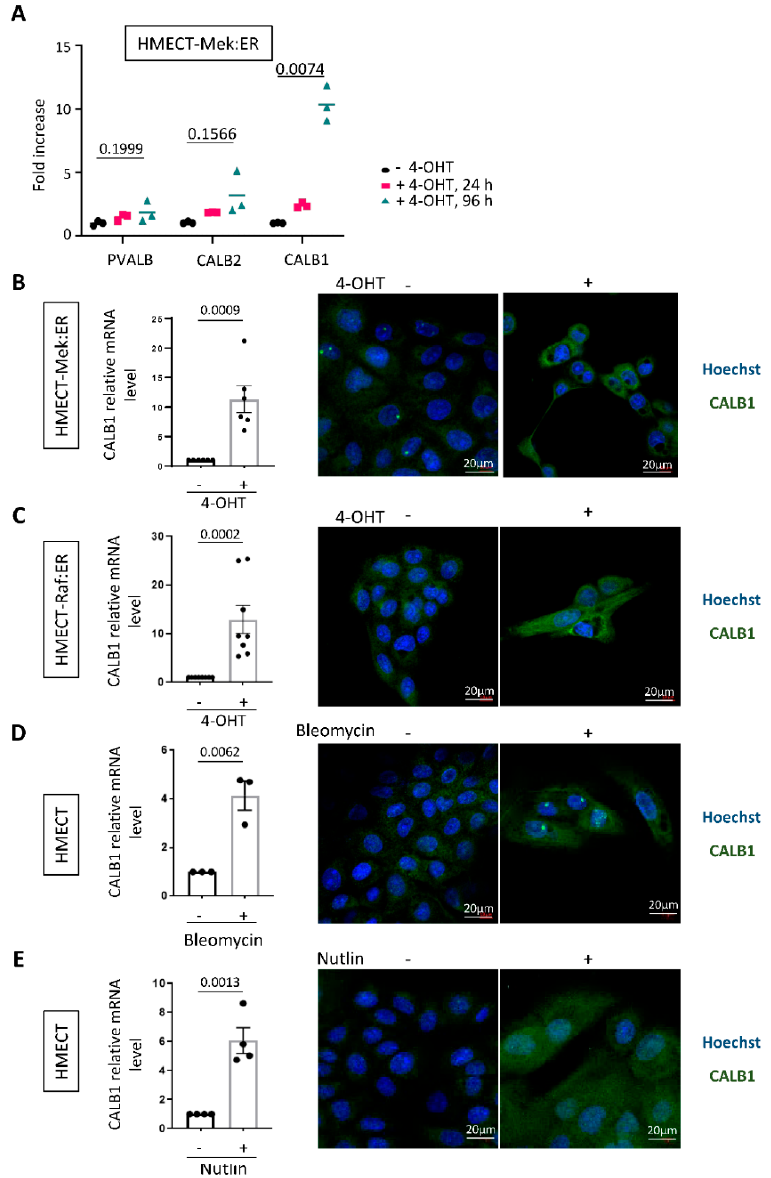
Figure 2. CALB1 expression is increased in HMECT in response to diverse senescence inducers. ( A ) Transcriptomics analysis in HMECT-Mek:ER reveals that CALB1 expression is induced after oncogene activation by 4-OHT. PVALB, CALB2, and CALB1 mean expression level from a biological triplicate is indicated at 0 ( − 4-OHT), 24 and 96 h after 4-OHT treatment. An unpaired t -test with Welch correction was used. ( B – E ). CALB1 mRNA level ( left panels) and protein level and subcellular localization ( right panels) were assessed in HMECT either overexpressing 4-OHT-inducible oncogenes Mek:ER ( B ) or Raf:ER ( C ) or treated with bleomycin ( D ) or nutlin ( E ). CALB1 mRNA level was measured by RT-qPCR and mean +/- SEM of independent experiments are shown (( B ), n = 6; ( C ), n = 8; ( D ), n = 3; ( E ), n = 4). Unpaired t -test ( B , D , E ) or Mann–Whitney test ( C ) were performed, and p -values are indicated. CALB1 protein level and localization were assessed six days after treatment by immunofluorescence with CALB1 antibody, nuclei were stained with